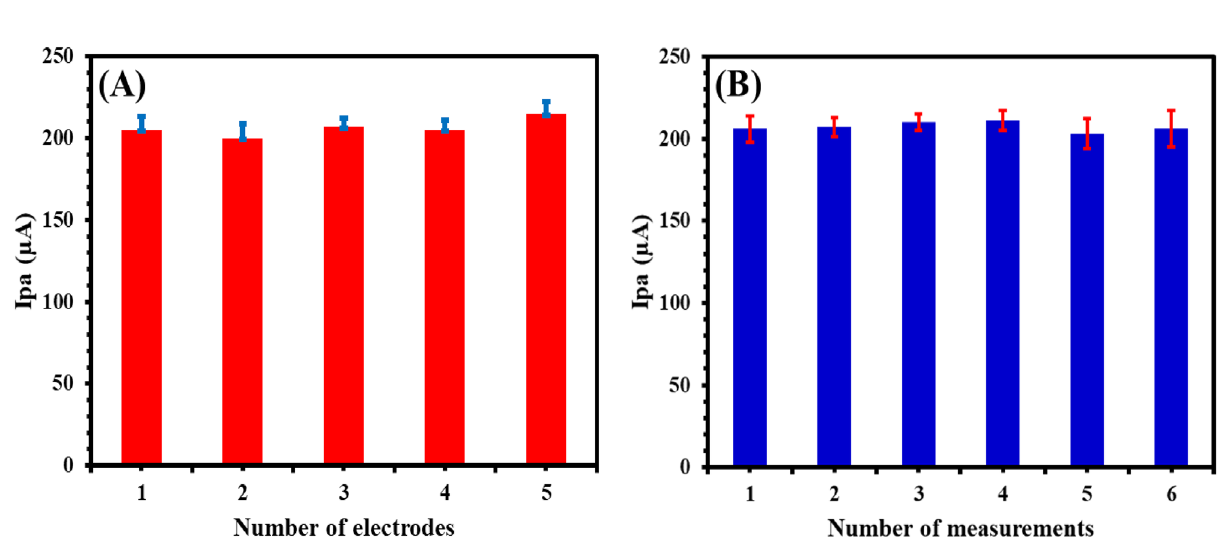
Figure 4. Reproducibility ( A ) and repeatability ( B ) of MIP-apt-AuNPs@ Fe 3 O 4 /GCE after incubation with of the 10 3 CFU mL -1 S. aureus in 0.1 M KCl containing 5.0 mM [Fe(CN) 6 ] 3−/4− . Conditions of DPV are pulse height of 30 mV, pulse width of 0.08 s and step height of 15